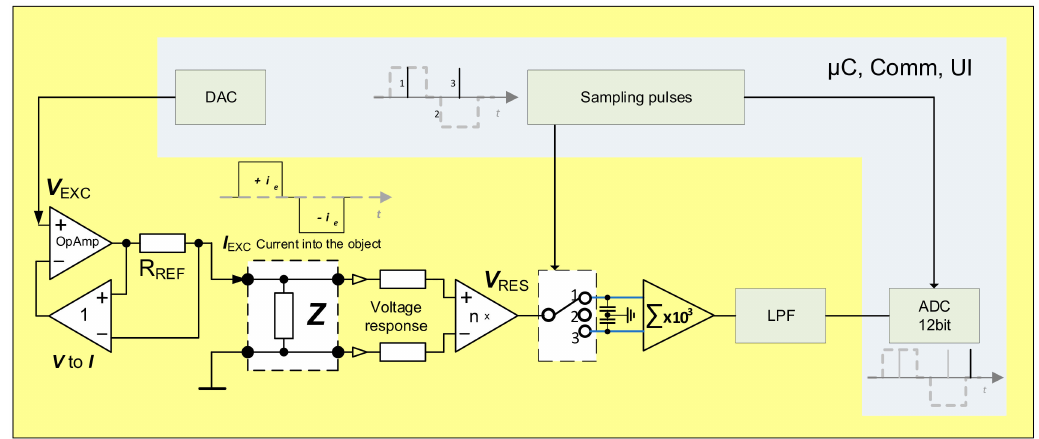
Figure 8. Simplified representation of the EBI measurement device with derivative sampling.